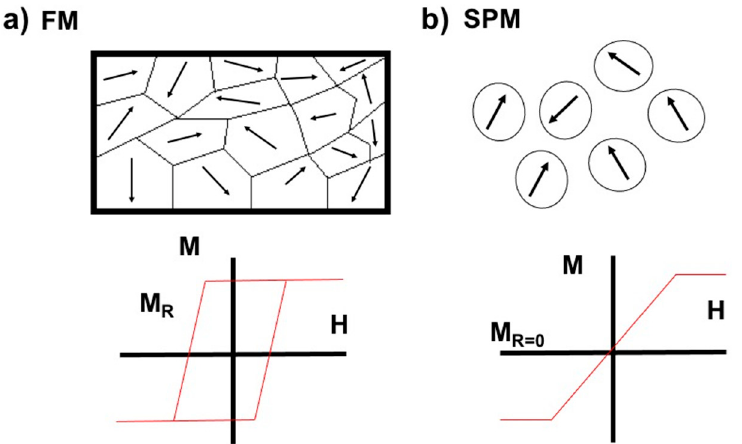
Figure 3. Magnetic behavior as function of the size of nanoparticles. ( a ) Materials made of ferromagnetic nanoparticles ( ∼ 50 nm in diameter) have multiple domains and remnant magnetization (M R ) after withdrawing the magnetic field. ( b ) Materials made of superparamagnetic nanoparticles (10–20 nm in diameter) do not have multiple domains or remnant magnetization after magnetic stimulus is withdrawn. FM (ferromagnetic), SPM (Superparamagnetic). Modified from Krishnan et al., 2010 [41] .